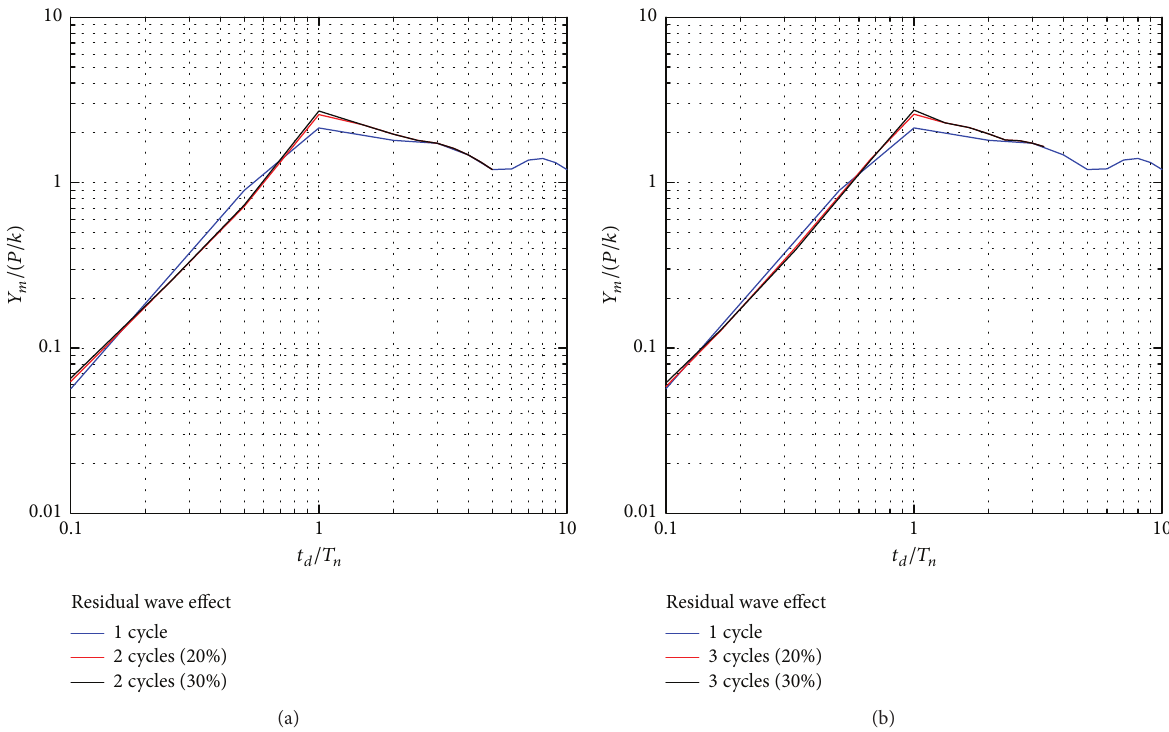
Figure 12: The results for maximum displacement response of single degree of freedom model according to the number of cycles: (a) 2 cycles; (b) 3 cycles.